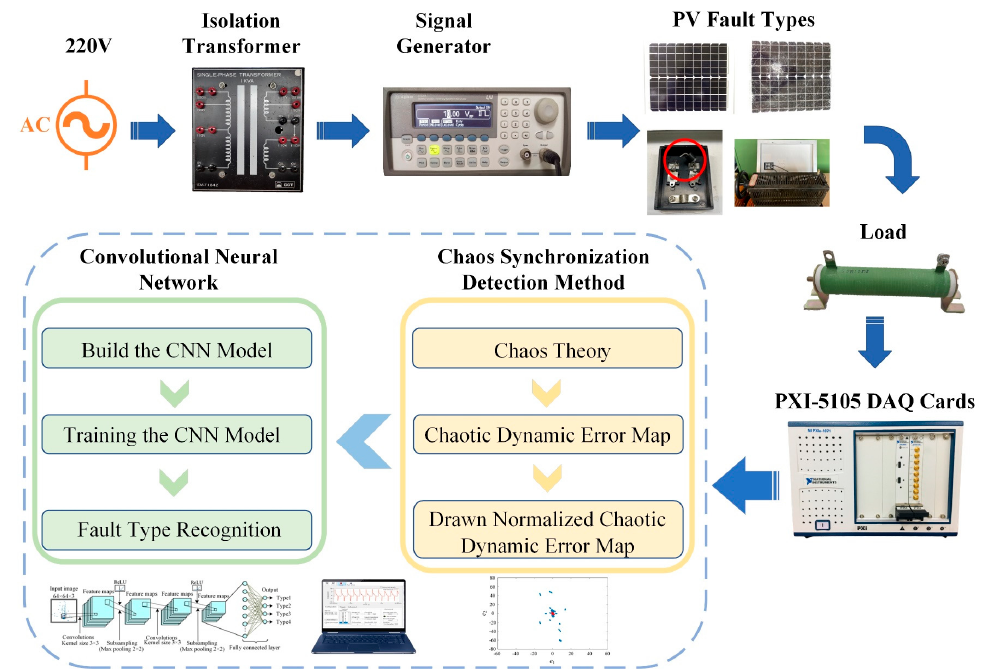
Figure 10. The algorithmic procedure.